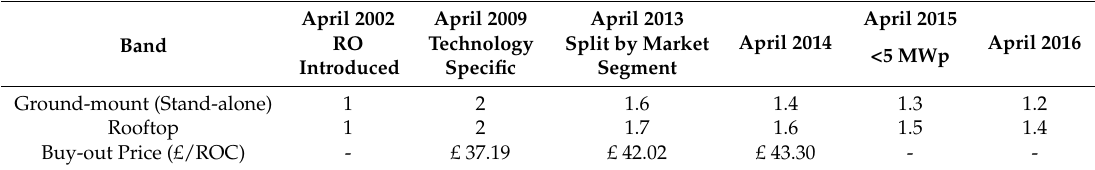
Table 1. Renewables obligation (RO) policy evolution, number of ROC/MWh available for PV and ROC buy-out price (£/ROC). RO certificate: ROC.